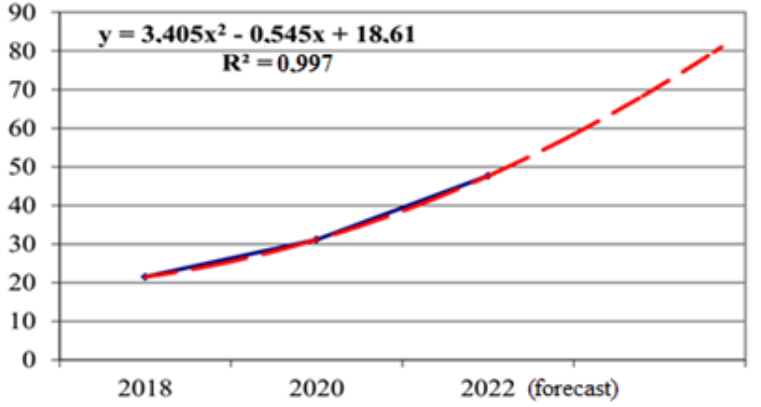
Figure 10. Integrated risk assessment of industrial enterprises of the “Valley of Mechanical Engineering” cluster. Developed by VertakovaYu.